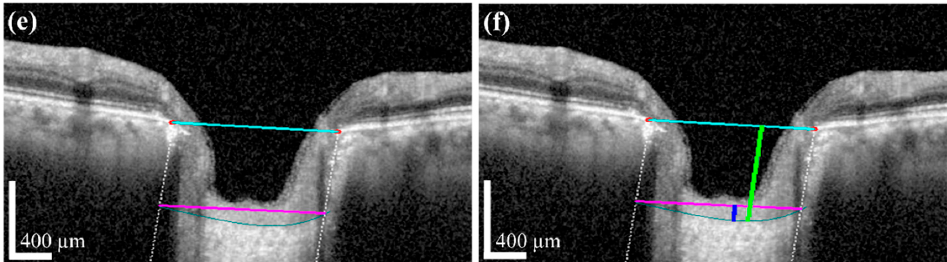
Figure 11. Results of each image processing step for quantification: ( a ) Original OCT image for investigation. ( b ) Proposed deep learning model and post-processing are performed to obtain the LC boundary curve of the BMO points. ( c ) Acquired information after post-processing and two BMO points (red dots) were connected to create a BMO reference line (cyan color line). ( d ) and ( e ) A vertical dotted line is lowered at two BMO points, and the points meet with the two ends of the anterior LC curve (teal color curve) and create a new line to connect with the two ends of the anterior LC curve (magenta color line). ( f ) The line drawn perpendicular to the anterior LC curve and the BMO baseline is called LCD (lime green color line), and the straight blue color line drawn vertically between the width (w) and anterior LC curve is called LCCD . Scale bar: 400 µm.